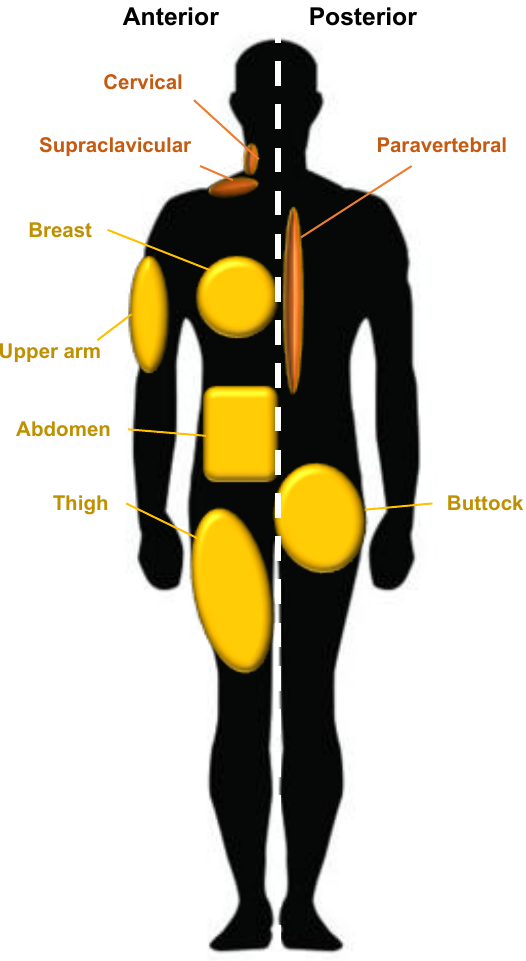
Figure 2. Adipose tissue distribution in humans. WAT is widely distributed around the body; principal WAT depots are illustrated in gold and BAT depots in brown. Silhouette indicates the anterior and posterior anatomical position on the left and right, respectively.